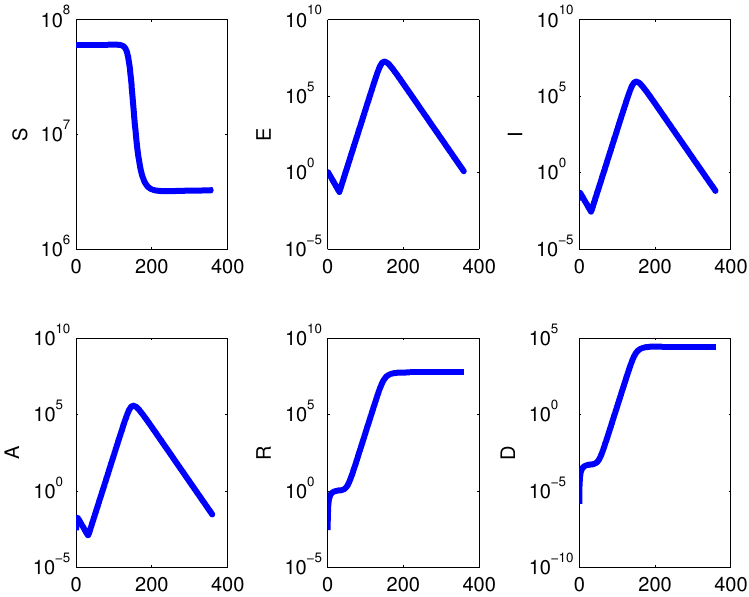
Figure 1. Using a semilogarithmic scale for the vertical axis, we show the results of starting the restrictions at time t 1 = 1, using β I = 10 − 10 and lifting them at time t 2 = 30, returning to β I = 10 − 7 one month later, over a one year timespan for the model with demographics (1). Left to right and top to bottom, the subpopulations are: S , E , I , A , R and D , the disease-related deceased